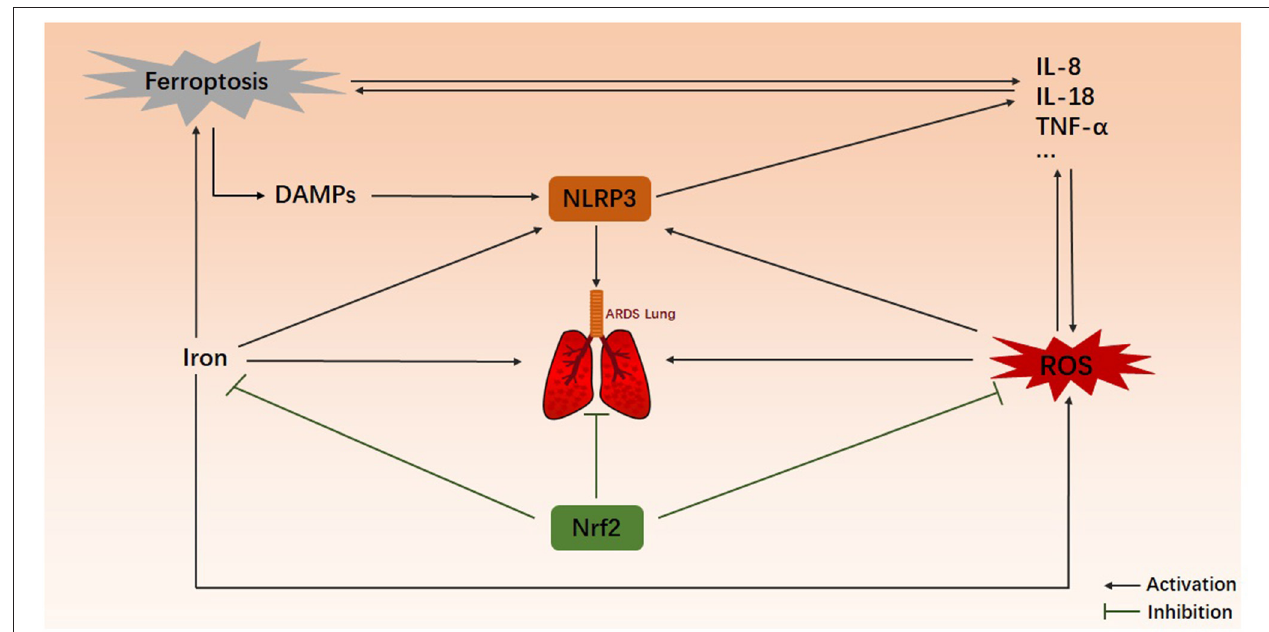
FIGURE 2 | Possible relationship between ferroptosis and ARDS. Here is an ARDS lung. DAMPs, ROS, and iron overload contribute to ARDS, and they can activate the NLRP3 inflammasome, which promotes the maturation and secretion of inflammatory factors, forming a self-amplifying loop with ferroptosis. Nrf2 inhibits the generation of ROS and iron to negatively regulate ferroptosis. However, the direct link between ferroptosis and ARDS is unclear. DAMPs, damage-associated molecular patterns; ROS, reactive oxygen species; NLRP3, NOD-like receptor protein 3; Nrf2, nuclear factor erythroid 2-related factor 2.